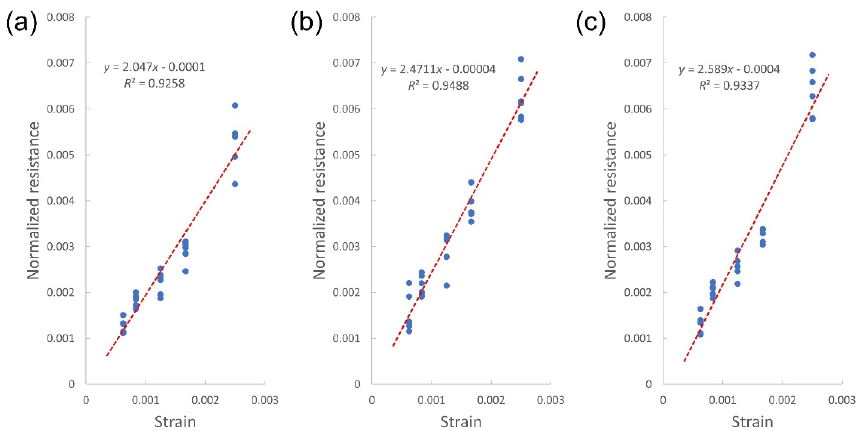
Figure 8. Gauge factor as a function of the width of printed strain-gauge patterns: ( a ) 2.047 for two droplets, ( b ) 2.471 for four droplets and ( c ) 2.589 for seven droplets.